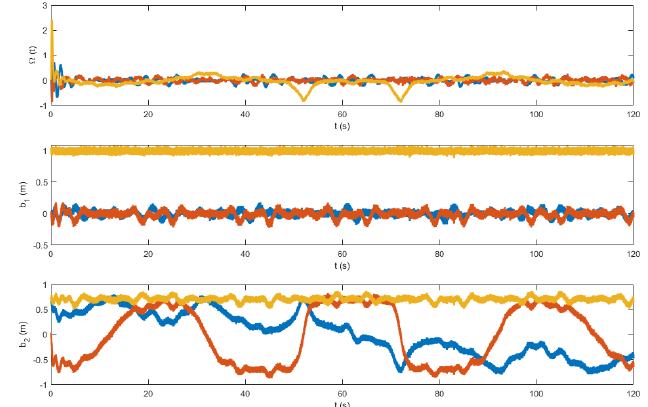
Figure 12. The vector measurements of the flight in terrain 1.